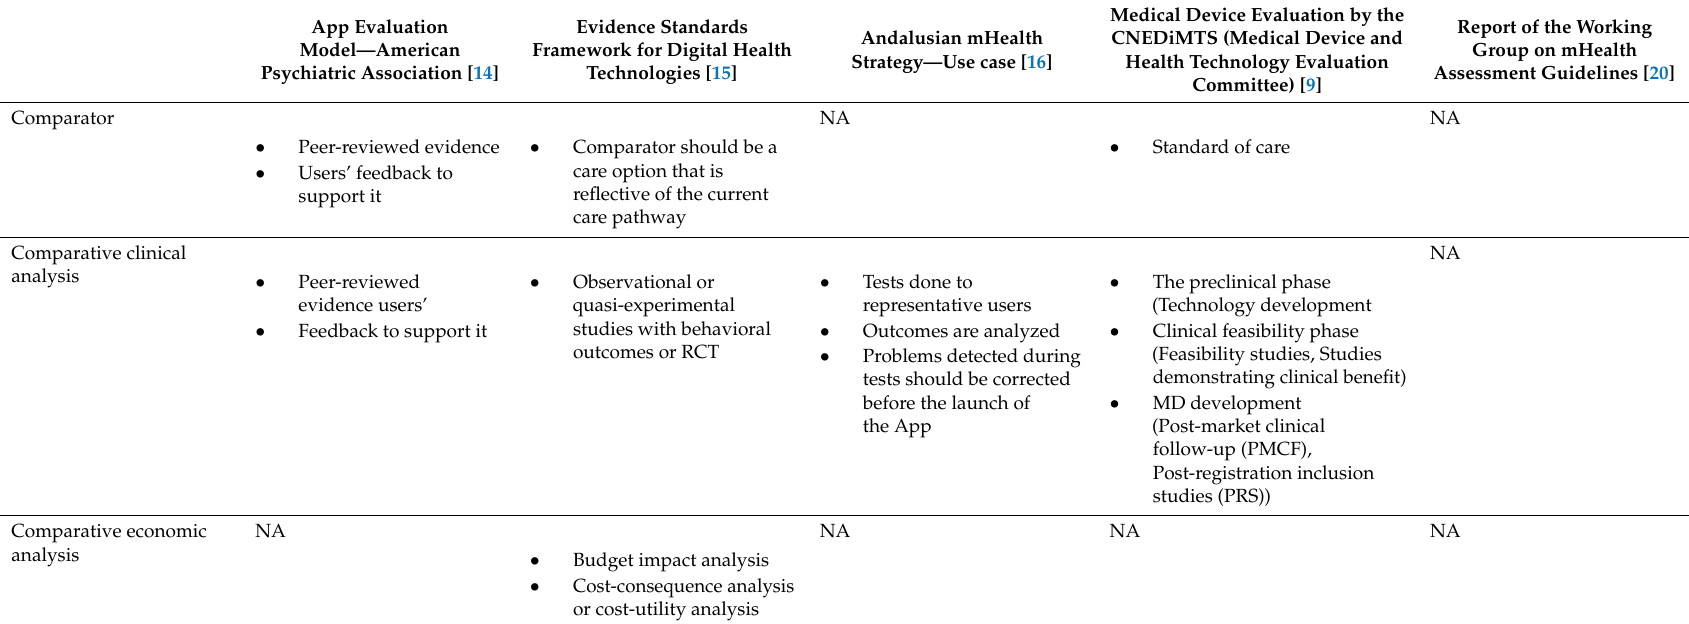
Table A6. Comparative